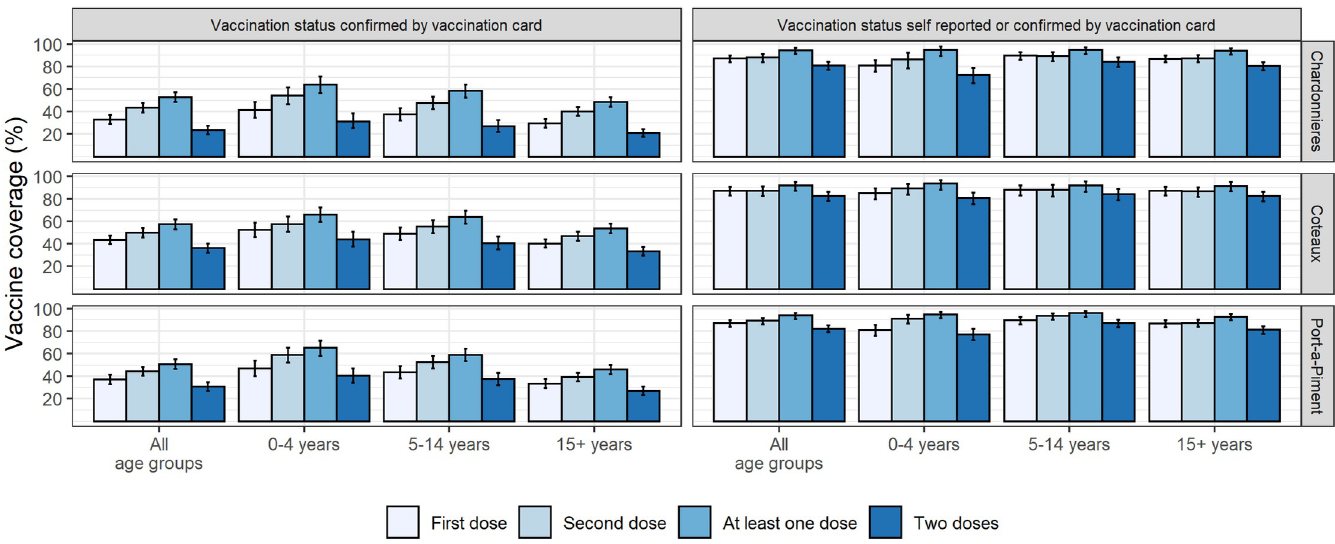
Fig 1. Cholera vaccination coverage by Commune, age group and assessment method, South Department, Haiti, 2017.